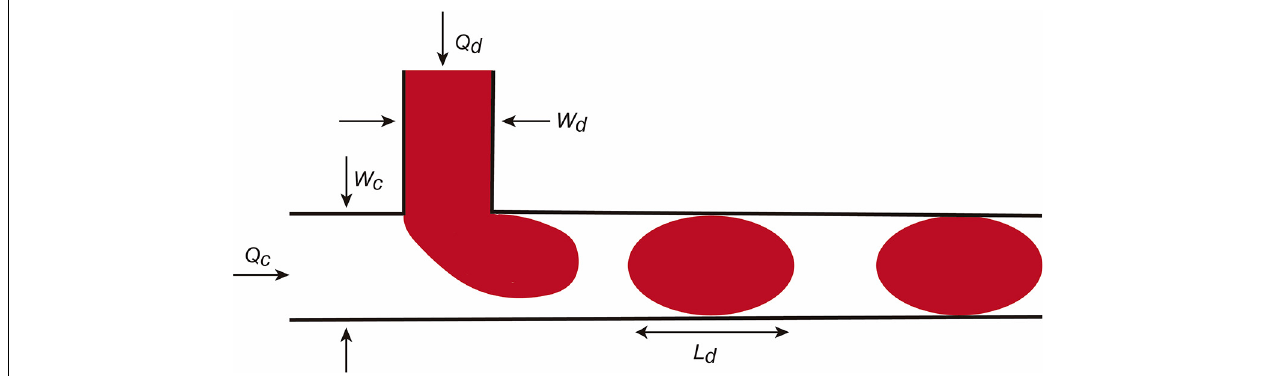
FIGURE 2 | Scheme illustrating micro/nanodroplet formation in a classical T-junction LOC. Please see the main text for details concerning the Q and W values. In this configuration, the dispersed phase is pumped into the continuous phase orthogonally. As the dispersed phase enters the continuous, shear forces elongate the head of the dispersed phase until a segment eventually separates and relaxes into a sphere or plug shape as a result of interfacial